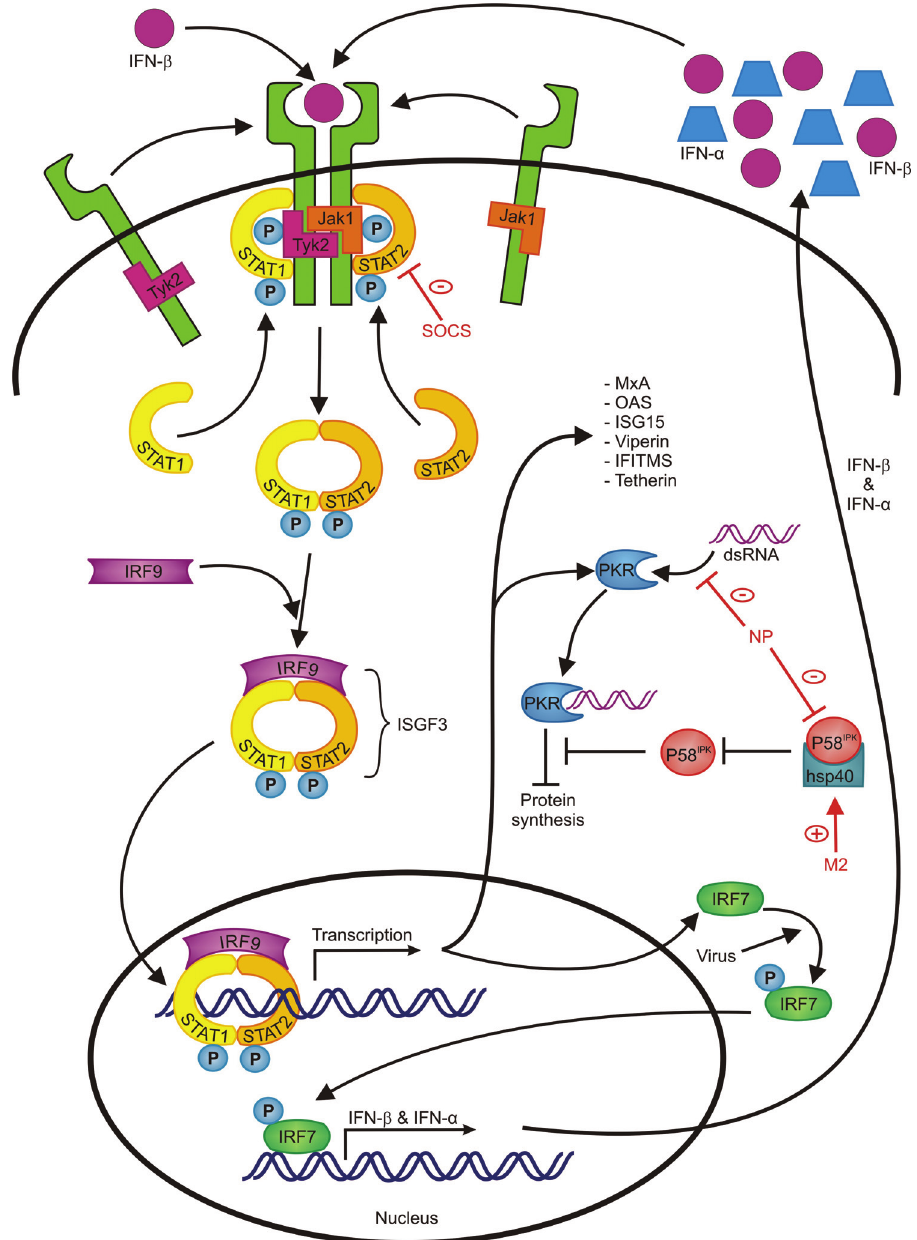
Figure 3. The type I IFN signaling pathway and inhibition by influenza A viruses (Figure adapted from [48]). IFN- β produced by influenza virus-infected cells binds IFN receptors causing the phosphorylation of Tyk2 and Jak1. This is followed by binding and phosphorylation of STAT1 and STAT2 which subsequently form a complex with IRF9. This ISGF-3 complex acts as a transcription factor for >300 genes, several of which display an antiviral effect (see text). The expressed protein PKR is activated upon recognition of viral dsRNA, leading to inhibition of protein synthesis, including viral proteins. PKR is inhibited by the cellular protein P58 IPK , however P58 IPK activity is downregulated by binding cellular hsp40. The IRF7 protein is phosphorylated in the presence of influenza A virus, leading to activation of a positive feedback loop, causing the transcription of IFN- α and IFN- β . Indicated in red are mechanisms of the influenza A virus to interfere with this pathway, these interfering mechanisms are explained more extensively in the